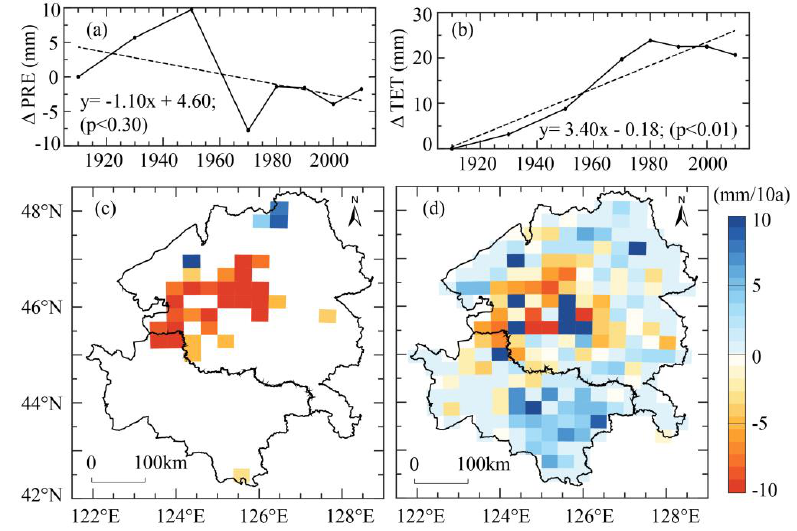
Figure 6. Trends of the plain-wide and grid-level deviations (against the 1910s) of the WRF-simulated precipitation ( a , c ) and total evapotranspiration ( b , d ) in growing season. In ( a , b ), the dashed lines are the linear correlation lines. In ( c , d ), only grids with significant trends are colored.